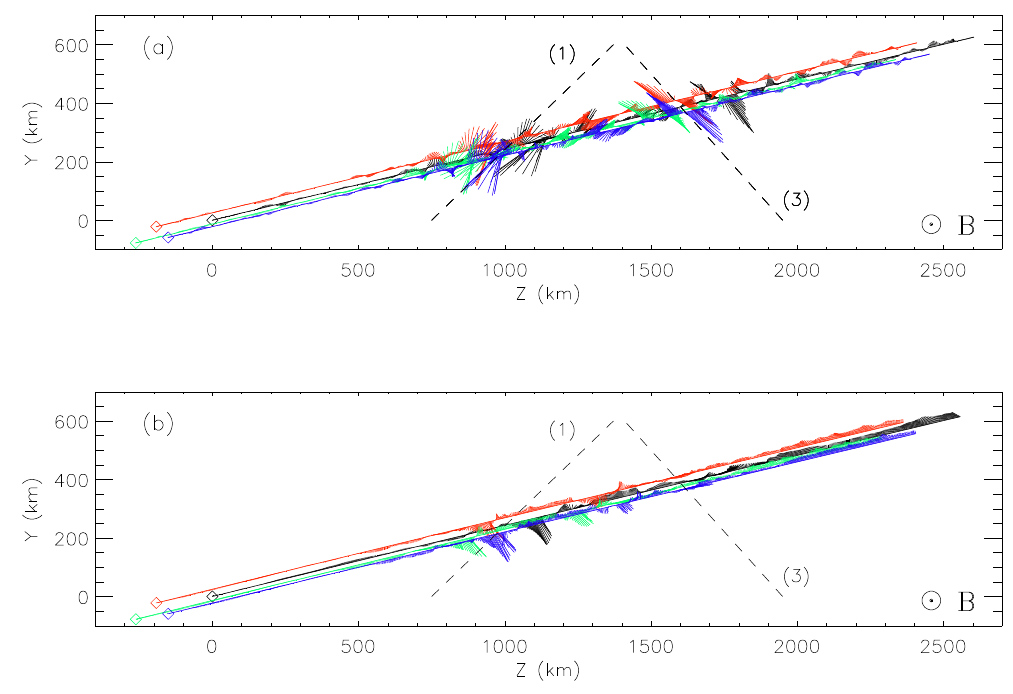
Fig. 3. Vector diagram of the residual magnetic field d B (a) and the electric field E (b) along the trajectories of the Cluster satellites, projected into a plane perpendicular to the magnetic field. As in Fig. 2, y and z are approximately to the geomagnetic west and north, respectively, and the colour coding is the same. Also indicated are the approximate orientations of the extended current sheets of regions (1) and (3), (see